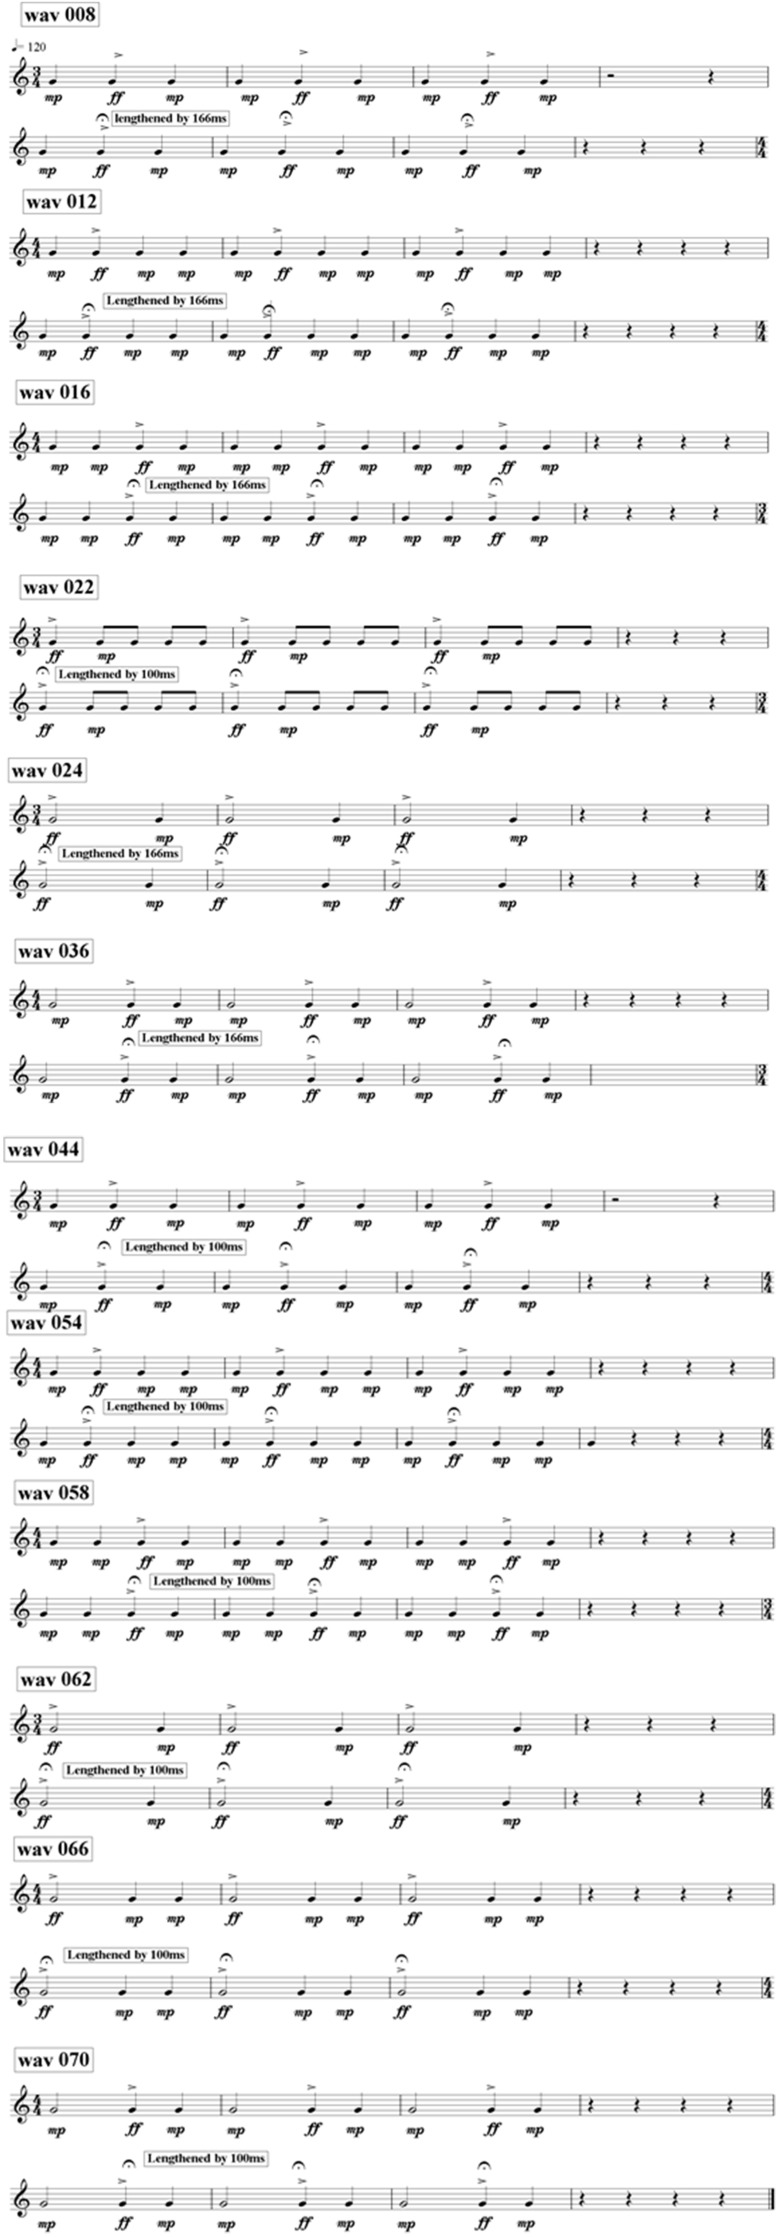
The “tunes” in the musical beat perception task. Reprinted from Goswami et al. (2013) with permission from Elsevier.